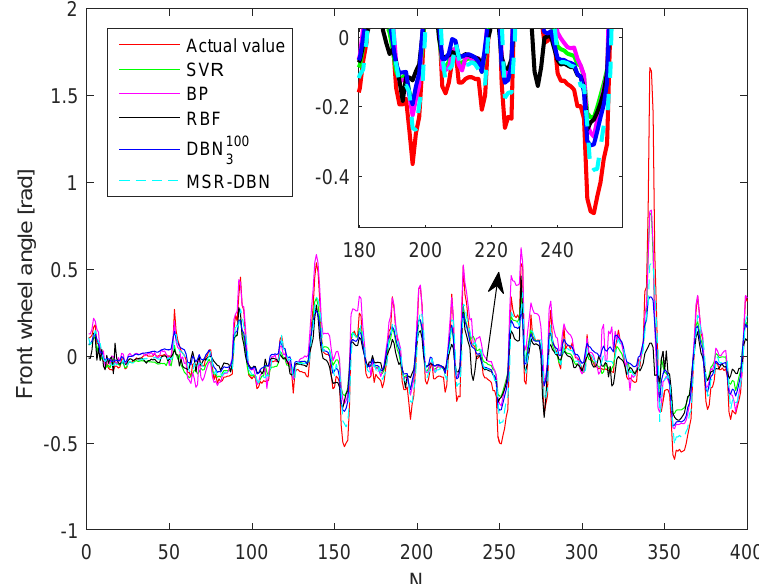
Figure 7. Prediction results of the front wheel angle based on different